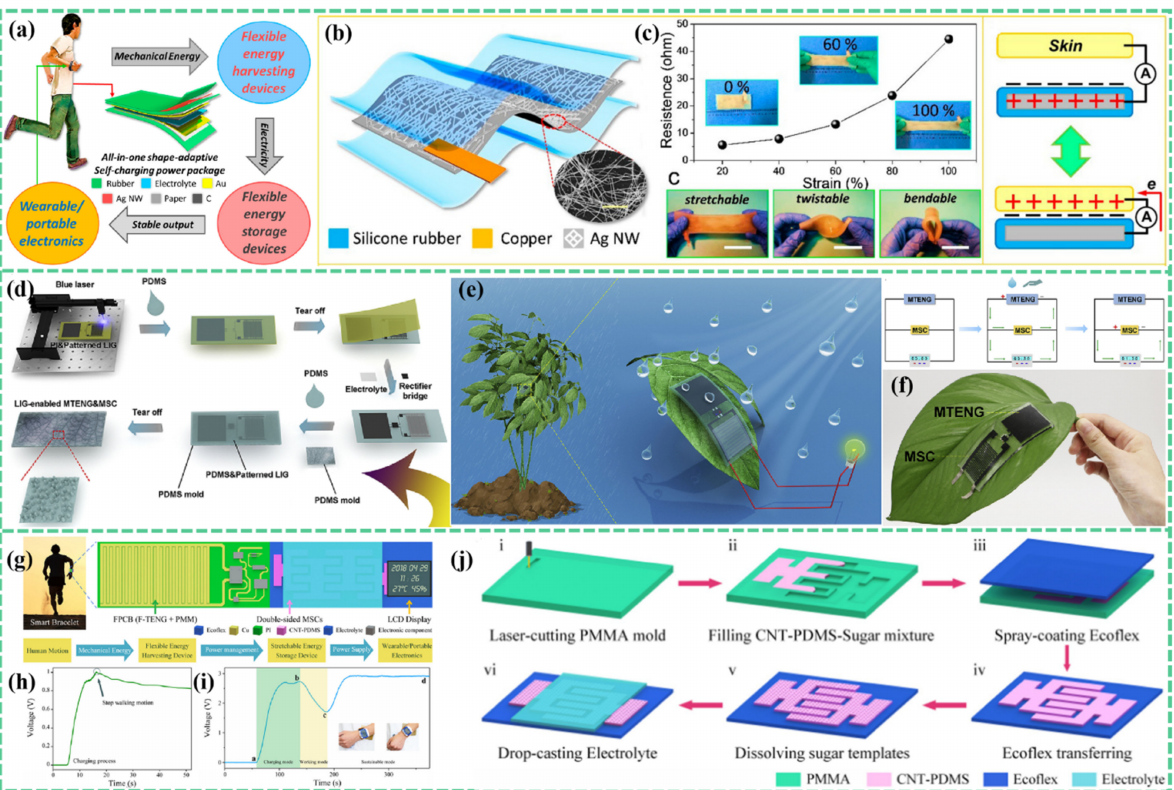
Figure 7. ( a – c ) All-in-one shape-adaptive TENG-UPS package for wearable electronics. ( a ) The working mechanism of the integrated adaptive self-charging module. ( b ) Structural scheme of the silicone rubber based flexible TENG. ( c ) Dependence of resistance of the Ag NW based electrode under various strain and the TENG under various mechanical deformations, stretching, twisting, and bending. Reproduced with permission [89]. Copyright 2016, American Chemical Society. ( d – f ) An integrated self-cleaning and self-charging device with bionic surface. ( d ) Schematic illustration of the fabrication process of device. ( b ) Digital photograph of lotus leaf. ( e , f ) Photo of the device attached to the leaf. Reproduced with permission [90]. Copyright 2020, Elsevier Ltd. ( g – j ) An uninterrupted power supply smart bracelet integrating an independent TENG, a power management module, and a D-MSC in the Ecoflex substrate. ( g ) Schematic diagram of efficient self-charging smart bracelet for portable electronic devices. ( h ) V-t curve during walking motion and self-discharge. ( i ) V-t curve in different modes. ( j ) Manufacturing process of tensile MSC. Reproduced with permission [91]. Copyright 2019, Elsevier